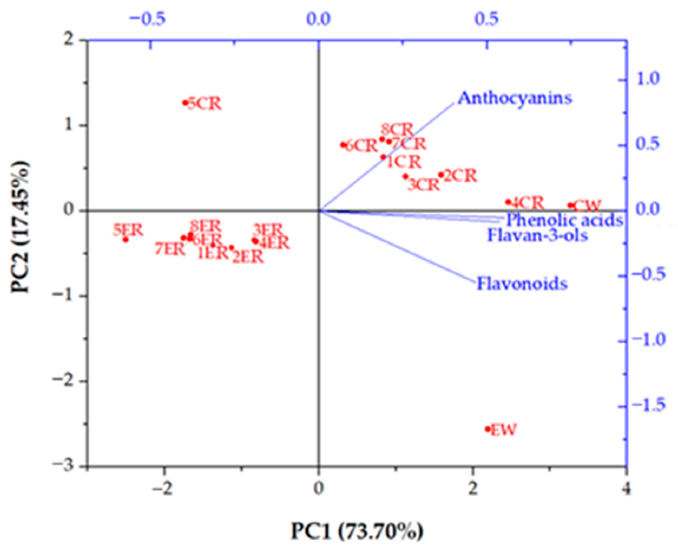
Figure 4. Principal component analysis (PCA) biplot of phenolic profiles of initial conventional and ecological red wines and their RO retentates. Abbreviations: CW—initial conventional wine; CR—